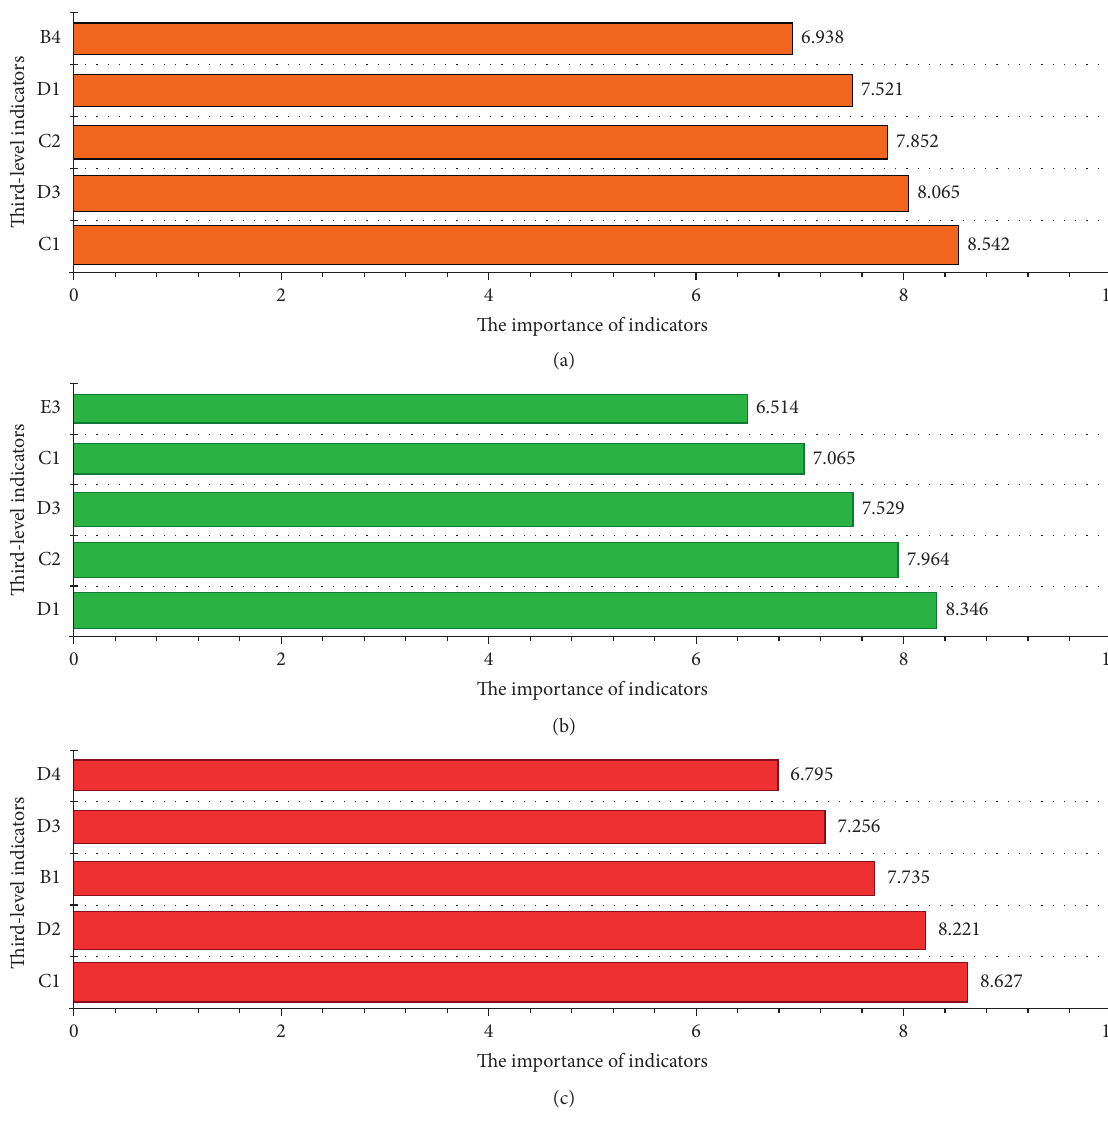
Figure 4: The five most important indicators measuring the livability of the urban community. (a) The preferences of the youth group. (b) The preferences of the middle-aged group. (c) The preferences of the elderly